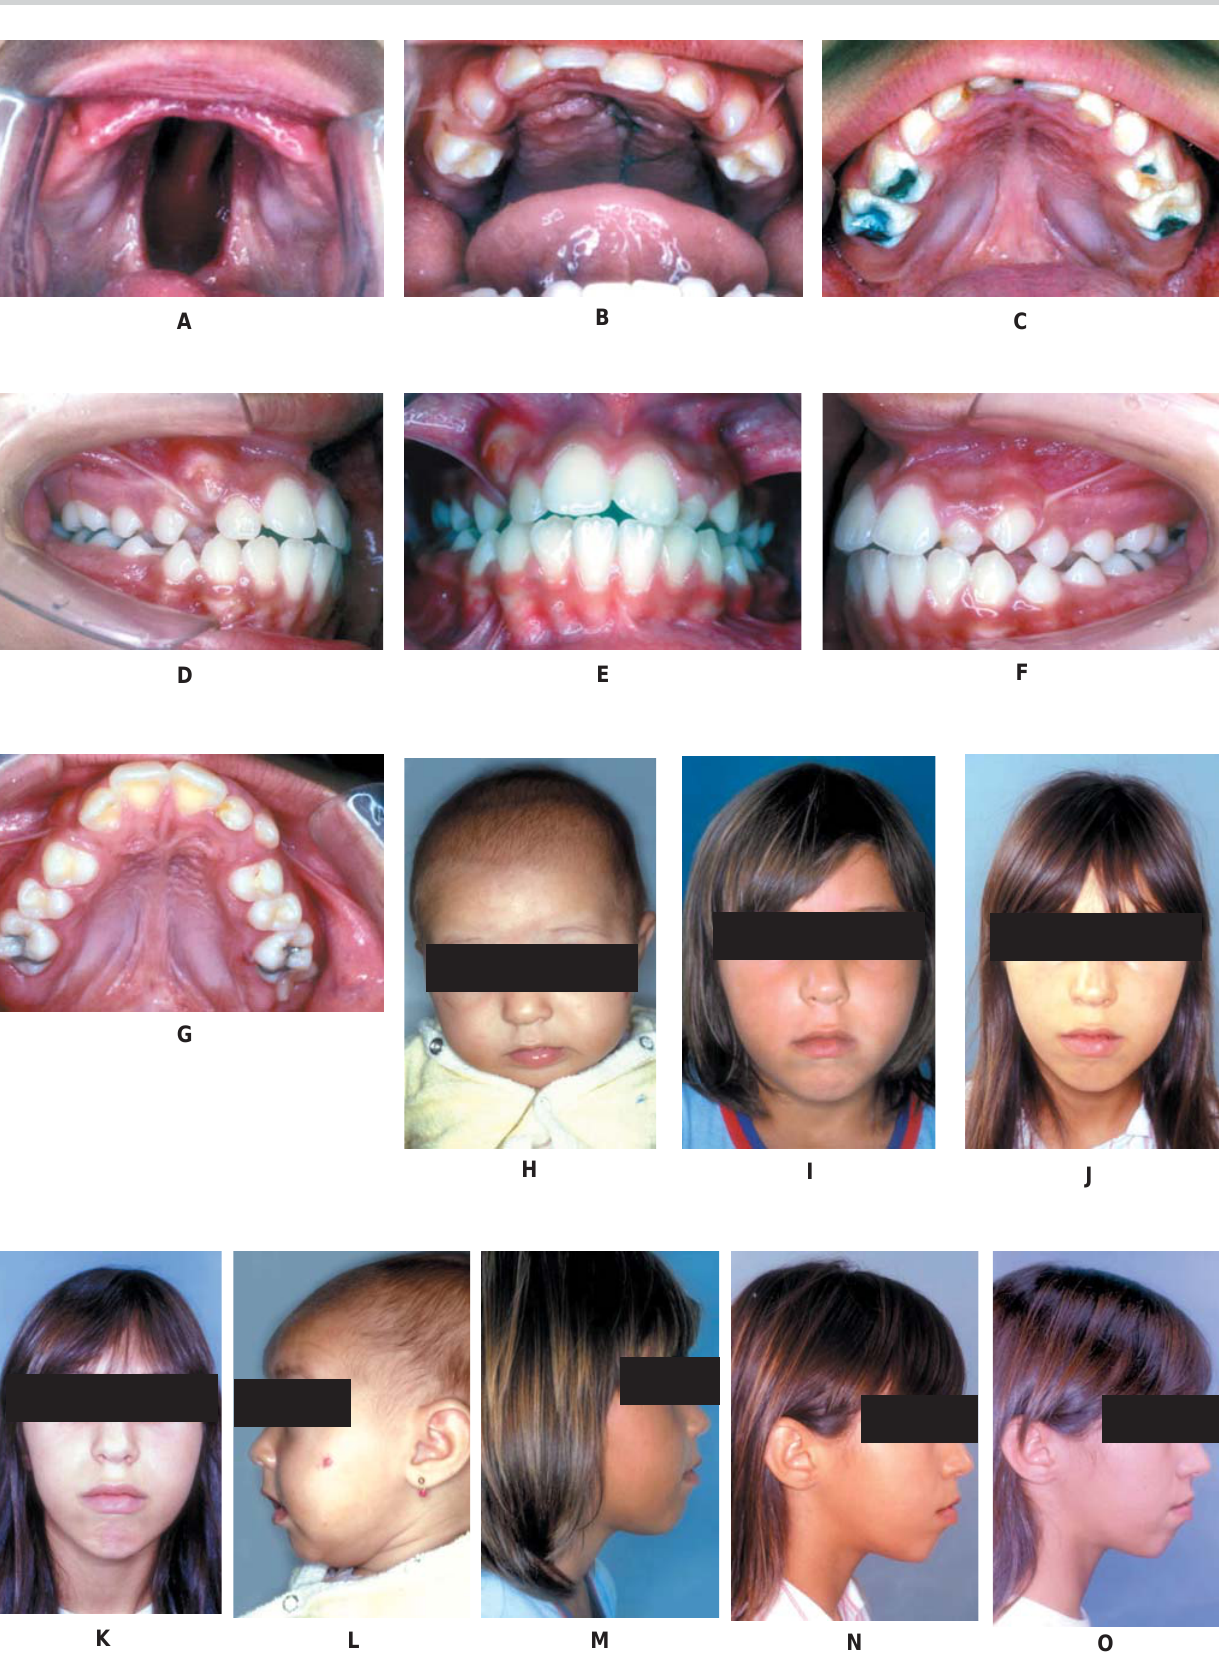
FIGURE 2- Patient with complete cleft palate. Photographs showing the diagnosis, plastic surgery and spontaneous development of occlusion and face. A) complete cleft palate (soft and hard palate), B) palatoplasty at 2 years of age for reconstruction of the palatal mucosa, C) integrity of palatal mucosa after palatoplasty. D) to G) intraoral views at 12 years of age, H) to O) frontal and lateral facial views at 4 months, 4, 10 and 12 years of